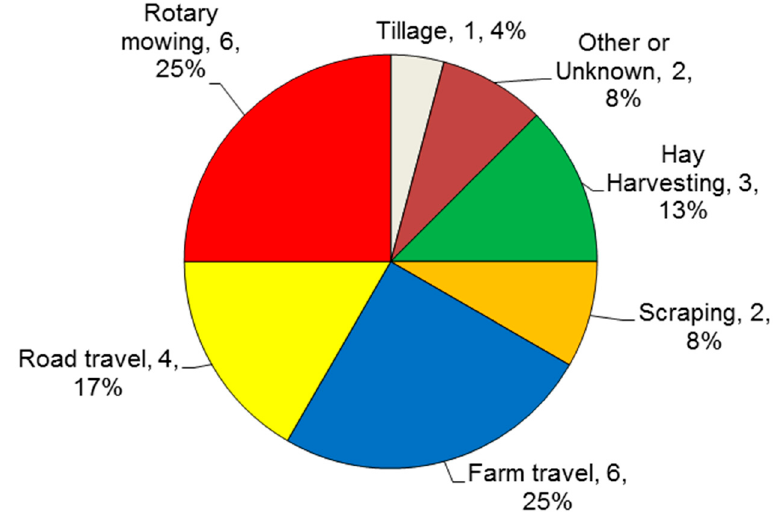
Figure 3. Chores associated with fatalities related to non-ROPS tractor overturns, n = 24.